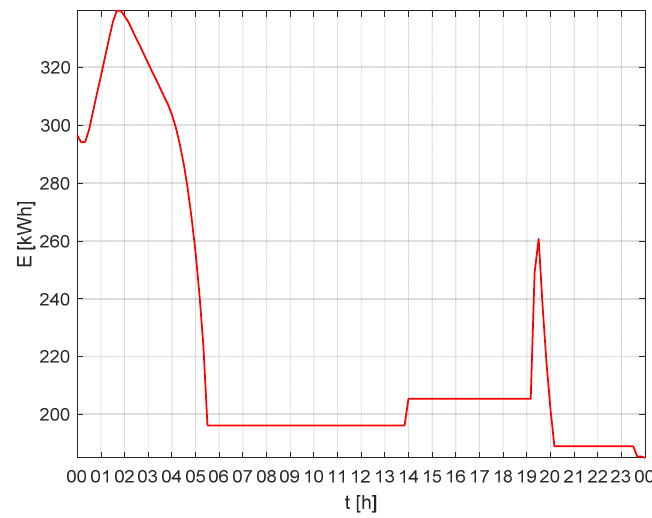
Figure 16. Results of the simulation of the operation of the private network with the BESS with real characteristics for a set exchange power of PM 400 kW; change of energy accumulated in the BESS over time.